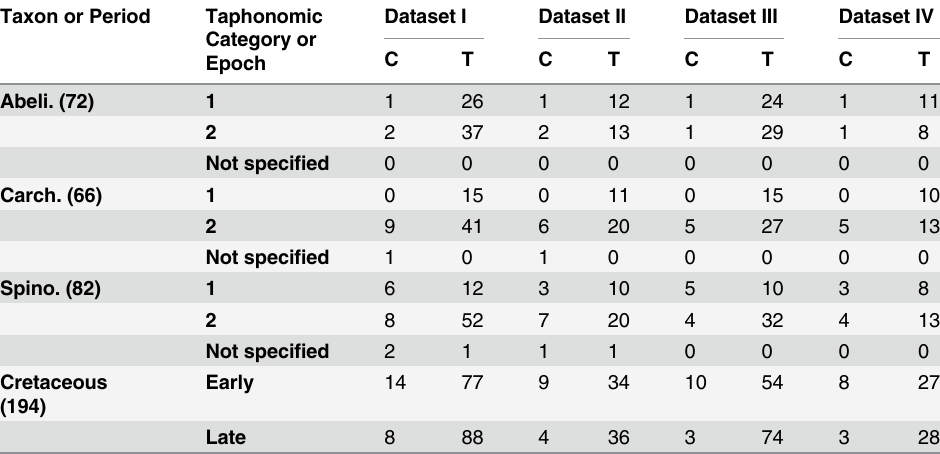
Table 1. Different datasets of occurrences. Taxon or